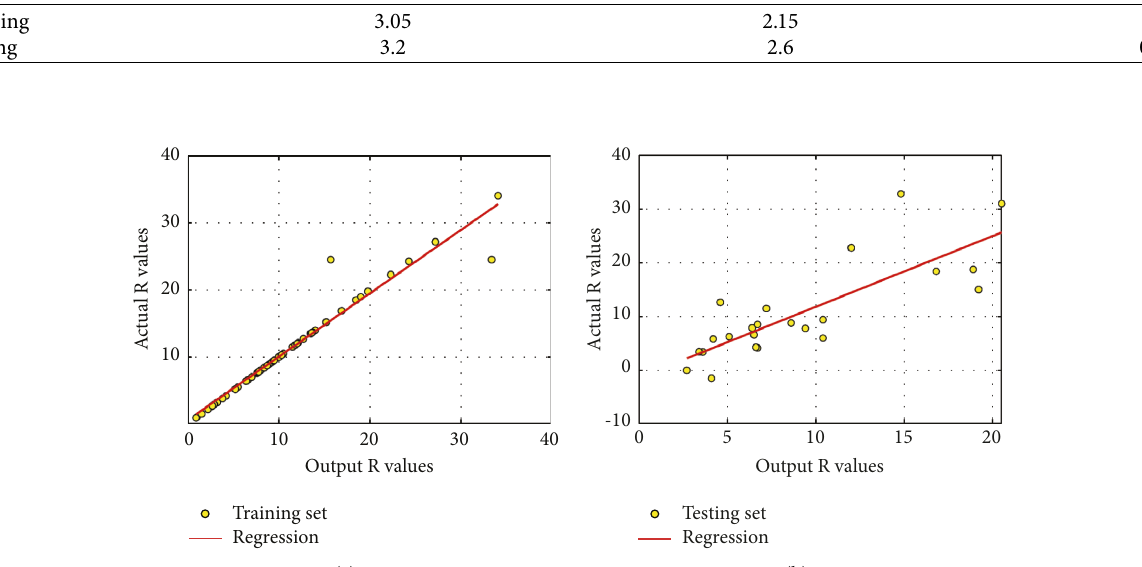
Figure 9: Regression analysis between experimental and simulation values calculated by DNN for (a) The training set; and (b) Testing